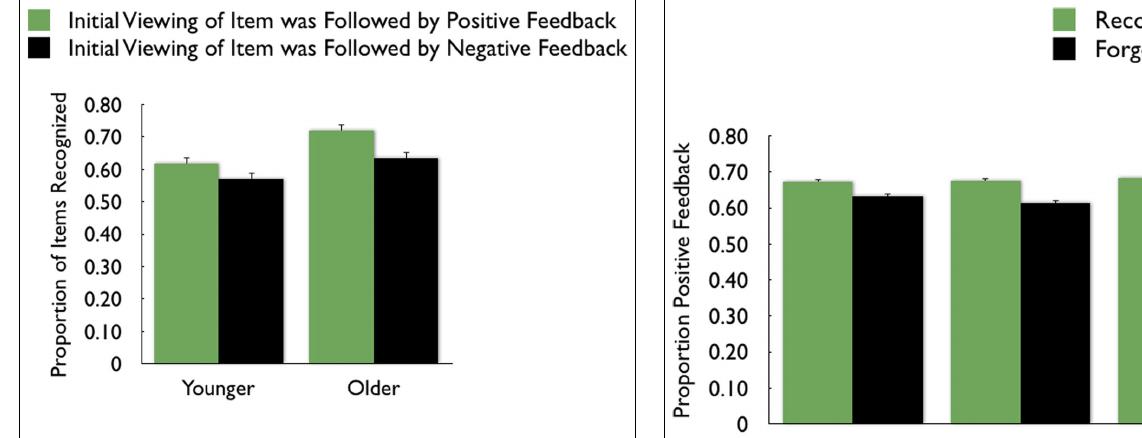
FIGURE 4 | Both younger and older adults were more likely to recognize pictures that were followed by positive feedback than those followed by negative feedback.